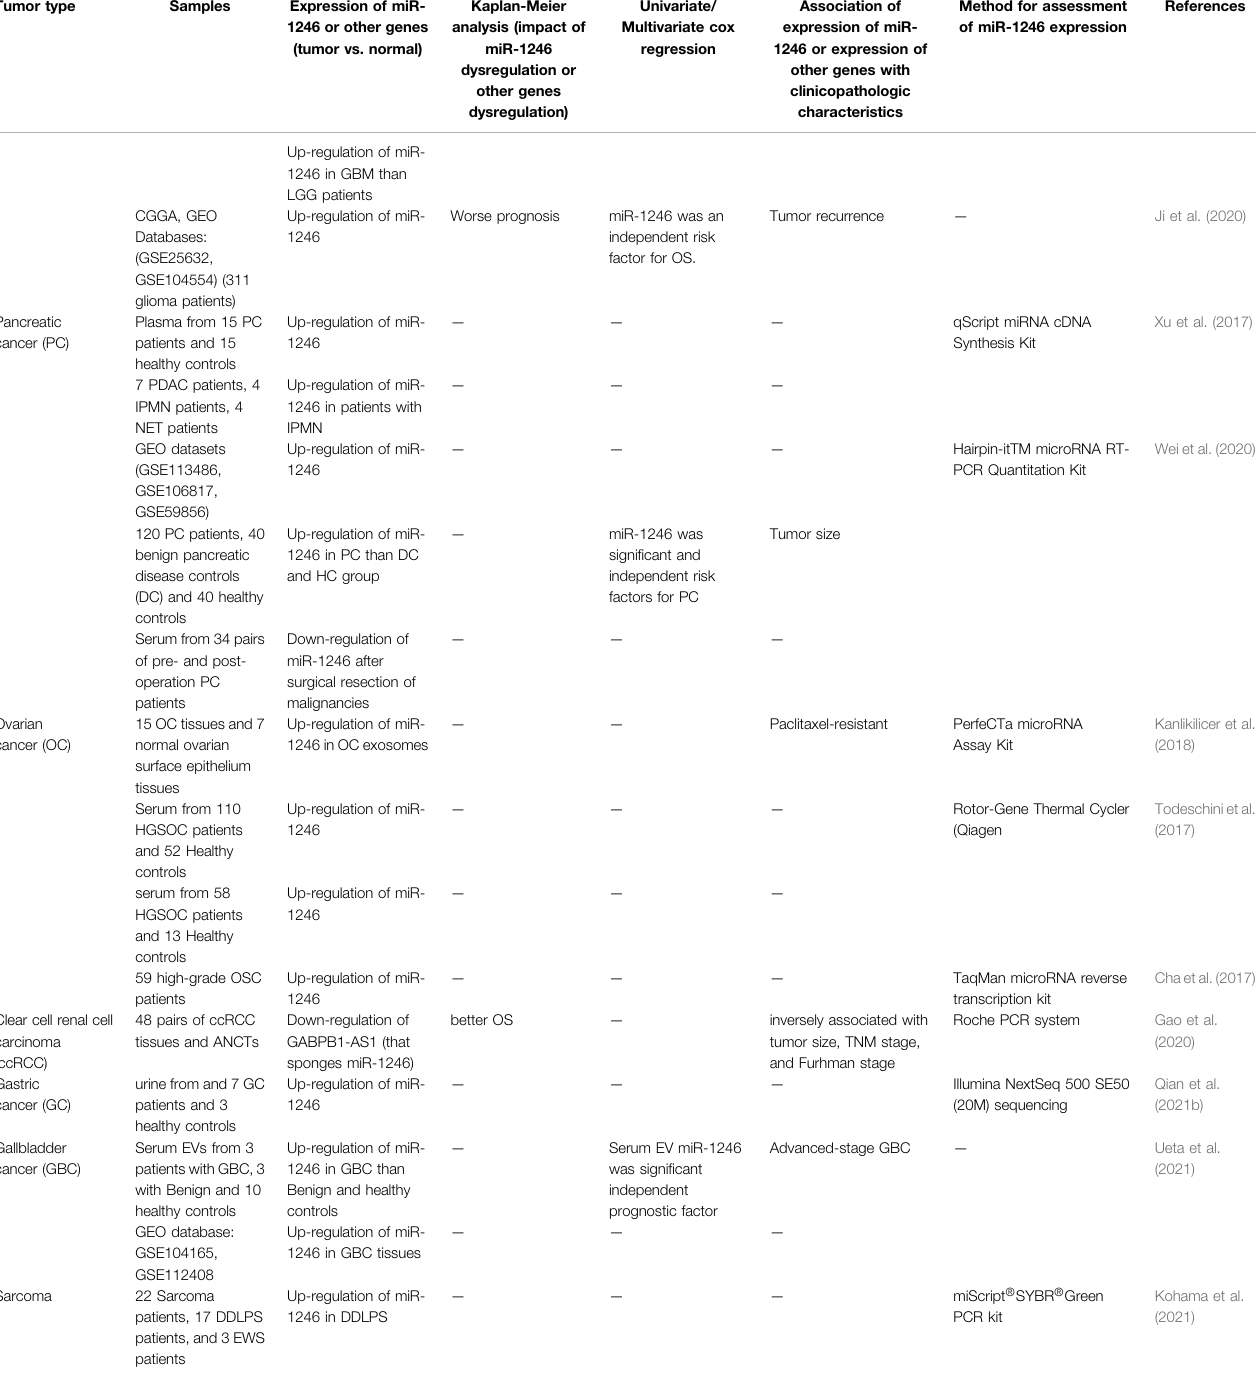
adenocarcinomas, IPMN: intraductal papillary mucinous neoplasms, NET: well differentiated neuroendocrine tumors, HGSOC: High-grade serous ovarian carcinoma, OSC: ovarian serous carcinoma, EVs: extracellular vesicles, DDLPS: